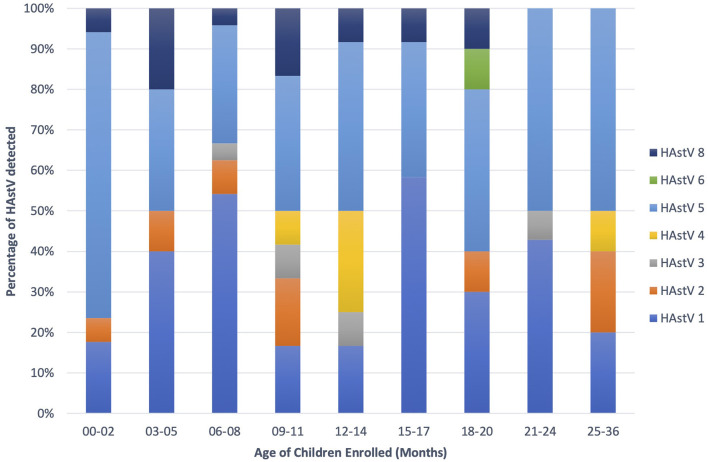
HAstV genotype distribution among age groups (0–36 months).